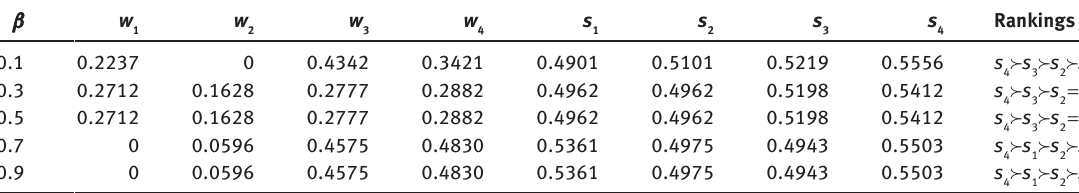
Table 2. Attribute Weights, Relative Closeness, and Rankings for Selecting Robots with Different β